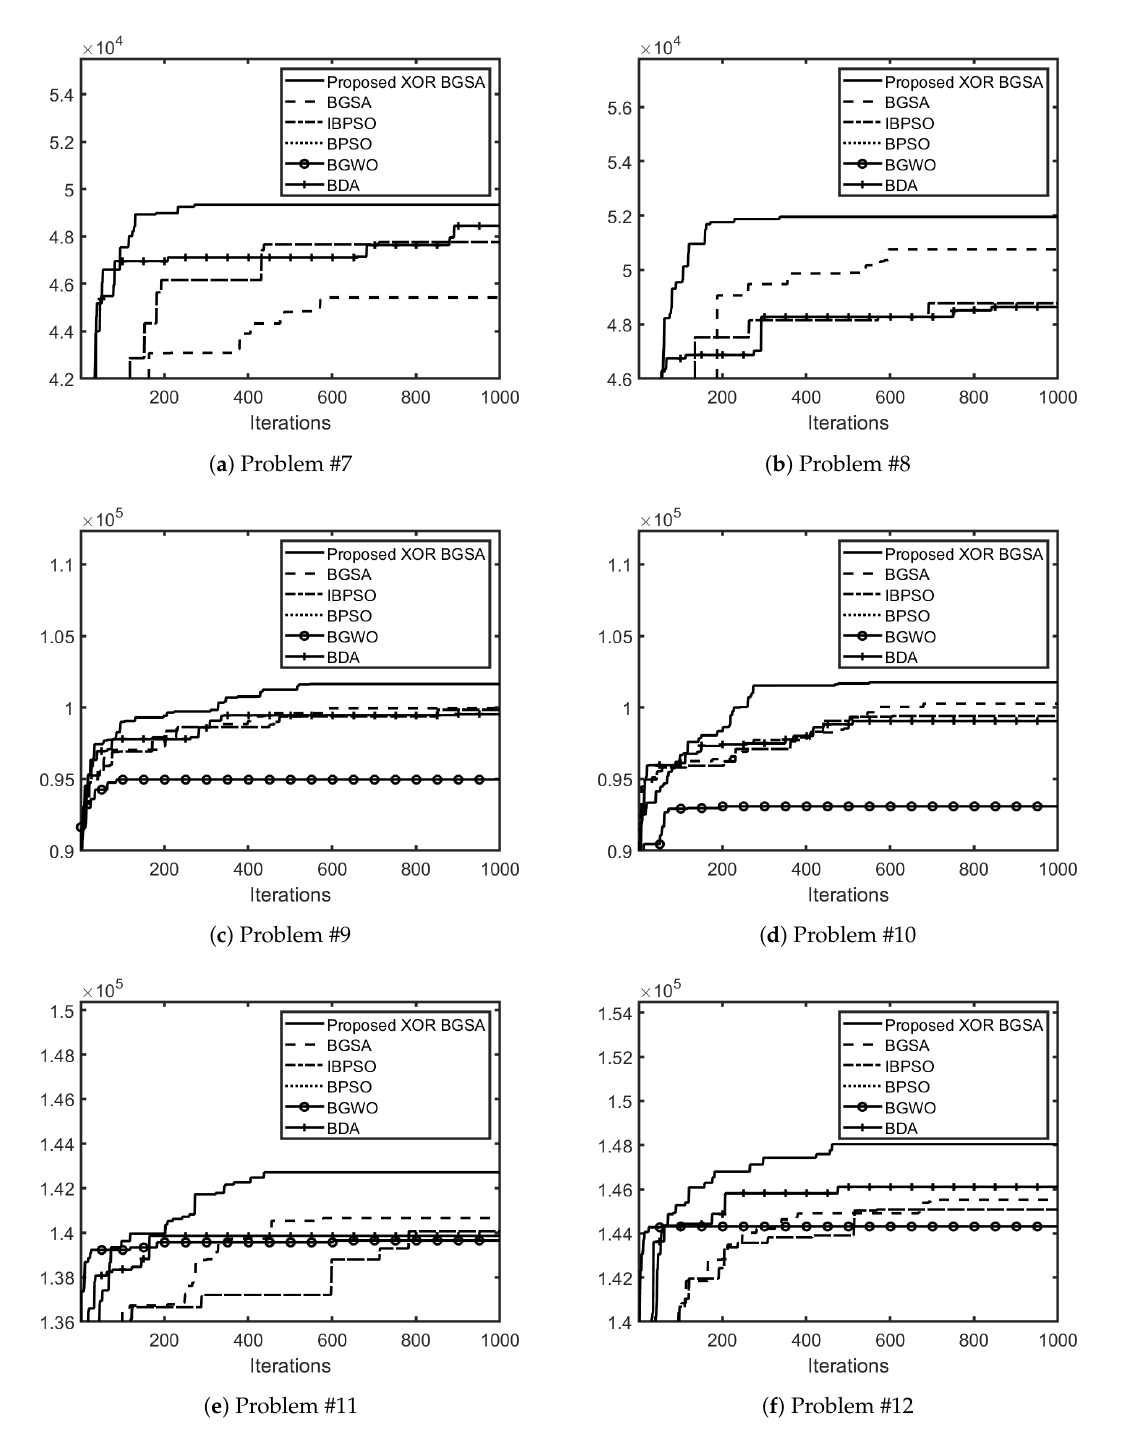
Figure 2. Trend of Cost function obtained from proposed XOR BGSA vs. four other algorithms namely: BGSA [16], improved binary particle swarm optimization (IBPSO) [17], binary particle swarm optimization (BPSO) [15], binary grey wolf optimization (BGWO) [18] and binary dragonfly optimization algorithm (BDA) [19]. Knapsack optimization problems numbers 7 to